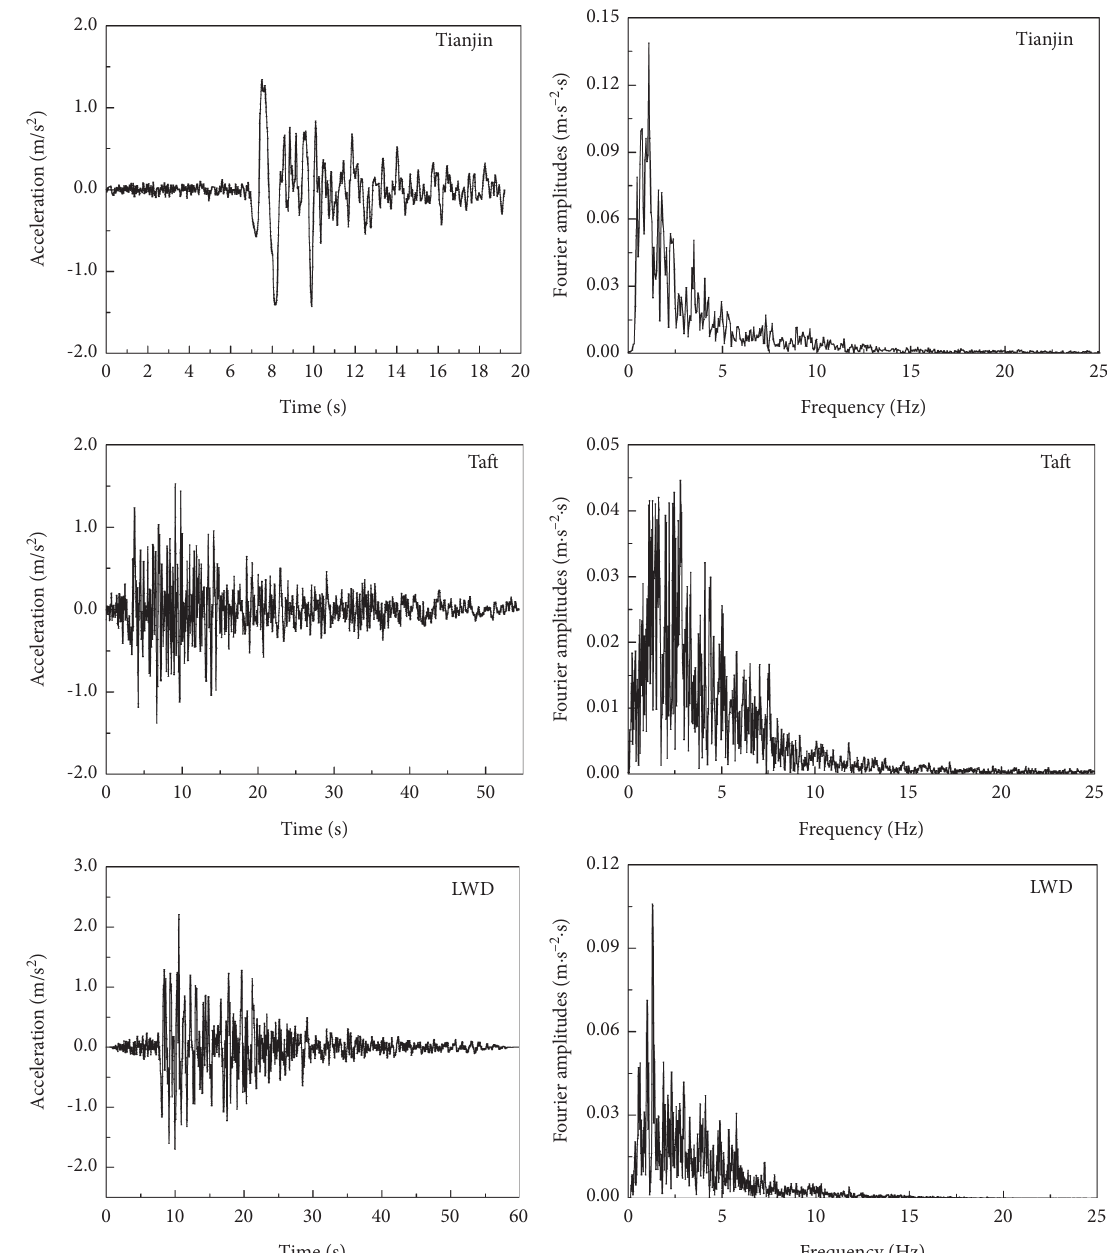
Figure 5: Acceleration time histories and Fourier spectra of ground